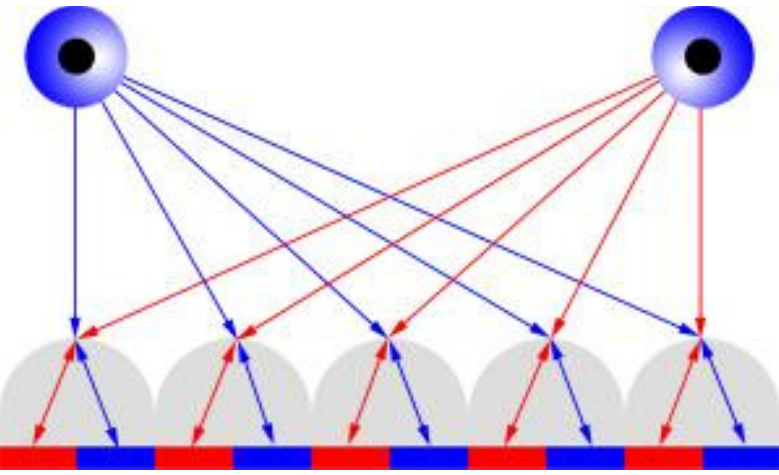
Figure 8. Lenticular